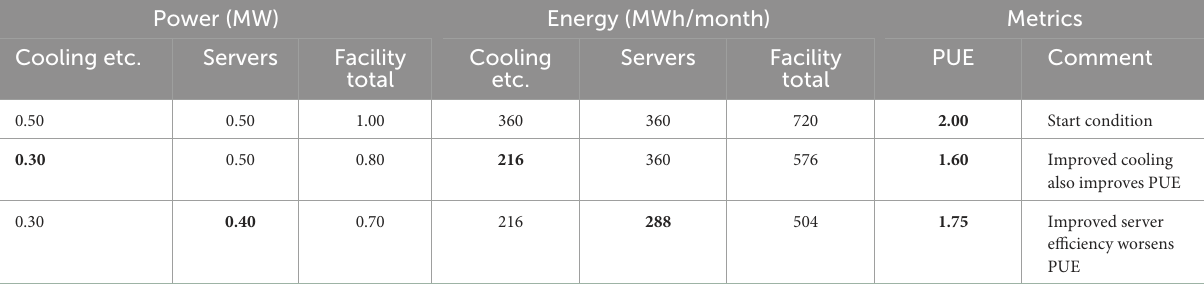
TABLE 1 PUE example. Power (MW) Energy (MWh/month) Metrics Cooling